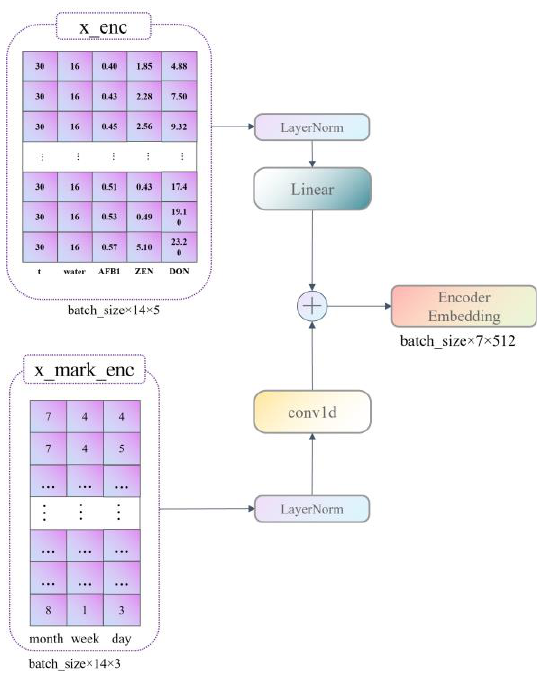
Figure 2. Encoder Embedding Construction Flowchart.